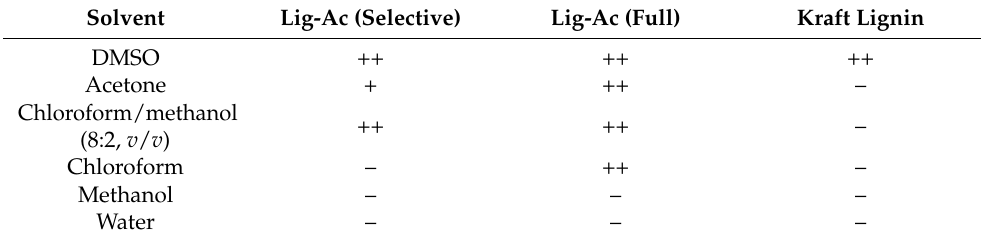
Table 2. Solubilities of Kraft lignin and acetyl derivatives. Solvent Lig-Ac (Selective) Lig-Ac